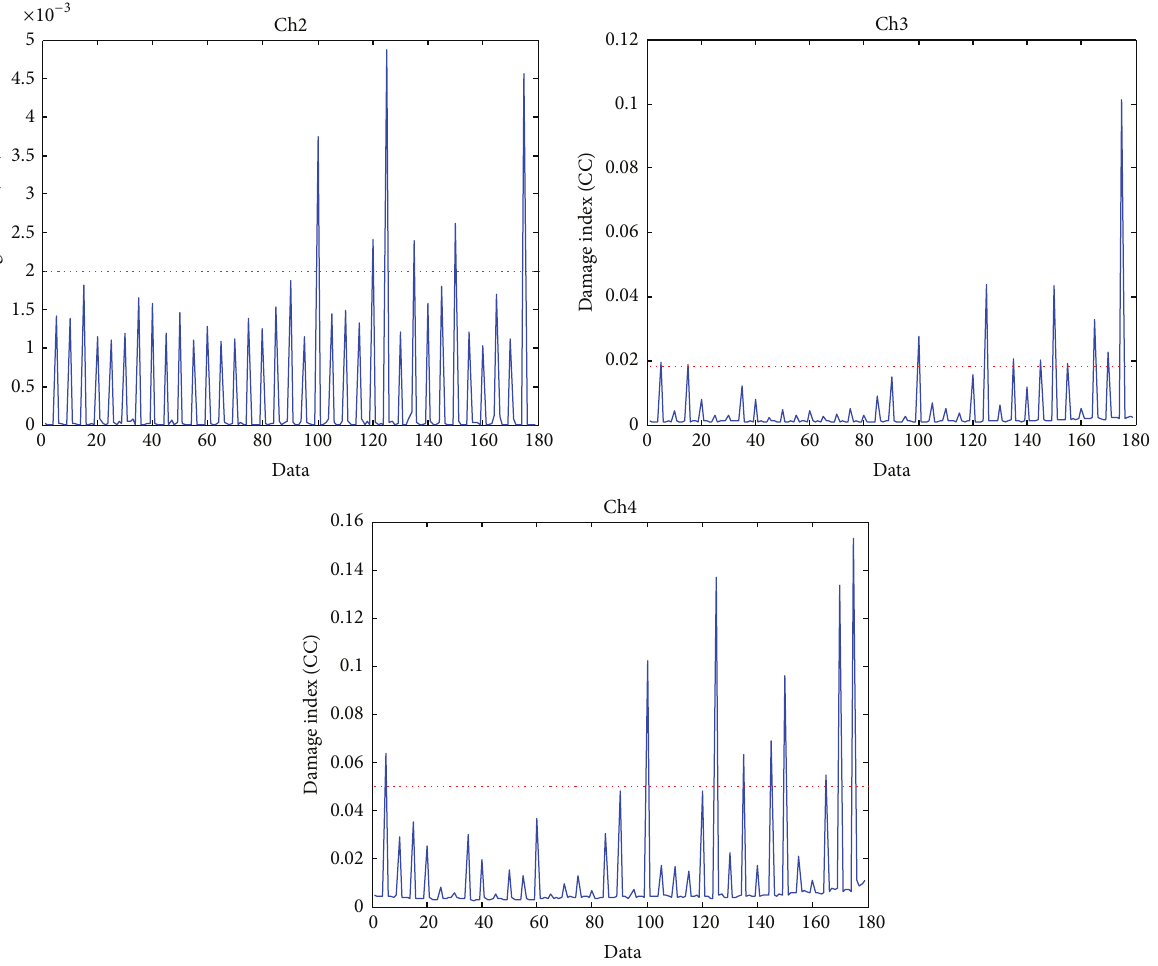
Figure 9: FRF-based DI values for Ch2–4. DI is measured between the current measurement and the previous